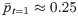
Resource management determines the formation of egalitarian social norm from diverse individual norms.The top row is for the intensity of resource management Δ = 0, and the bottom row is for the intensity of resource management Δ = 1. (a, e) Characteristic norm distribution of the initial state (a: p¯t=1≈0.25, q¯t=1≈0.25, e¯t=1≈0.665, c¯t=1≈0.729; e: p¯t=1≈0.253, q¯t=1≈0.25, e¯t=1≈0.666, c¯t=1≈0.728). (b, c, f, g) Time evolution of four population variables. (d, h) Characteristic norm distribution of the equilibrium state (d: p¯t=20,000≈0.061, q¯t=20,000≈0.02, e¯t=20,000≈0.917, c¯t=20,000≈0.979; h: p¯t=20,000≈0.358, q¯t=20,000≈0.315, e¯t=20,000≈0.915, c¯t=20,000≈0.973). Note the logarithmic scale on x-axis in (b, c, f, g). Parameter settings: exploration rate μ = 0, noise level K = 0.1 and learning error range ε = 5 × 10−3.